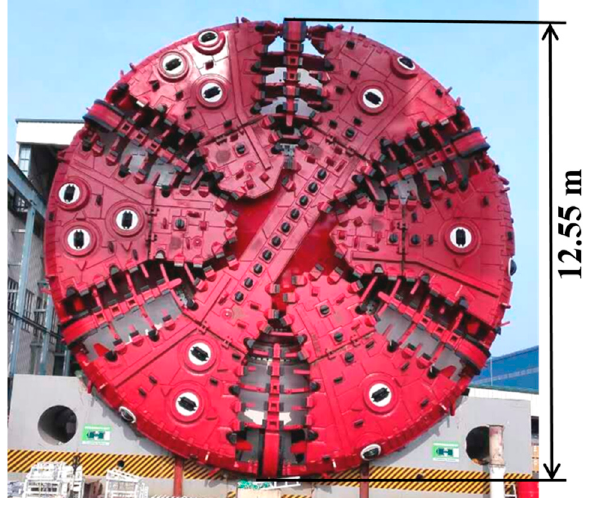
Figure 13. The cutting head used at the Wuhan Metro Line 8 Yangtze River Crossing tunnel construction.